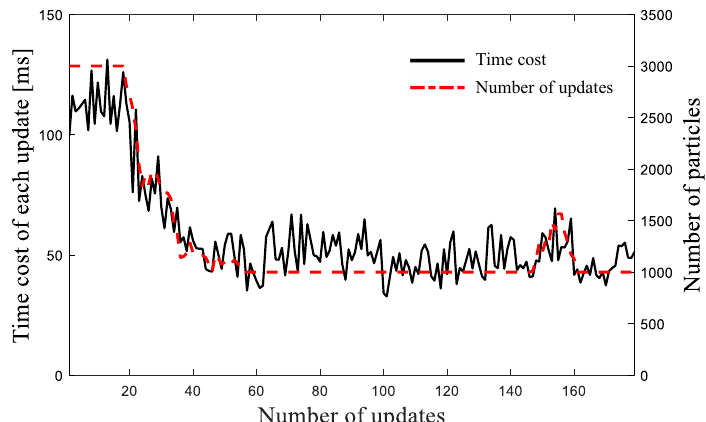
Figure 16. Runtime performance of the extended MCL algorithm’s each